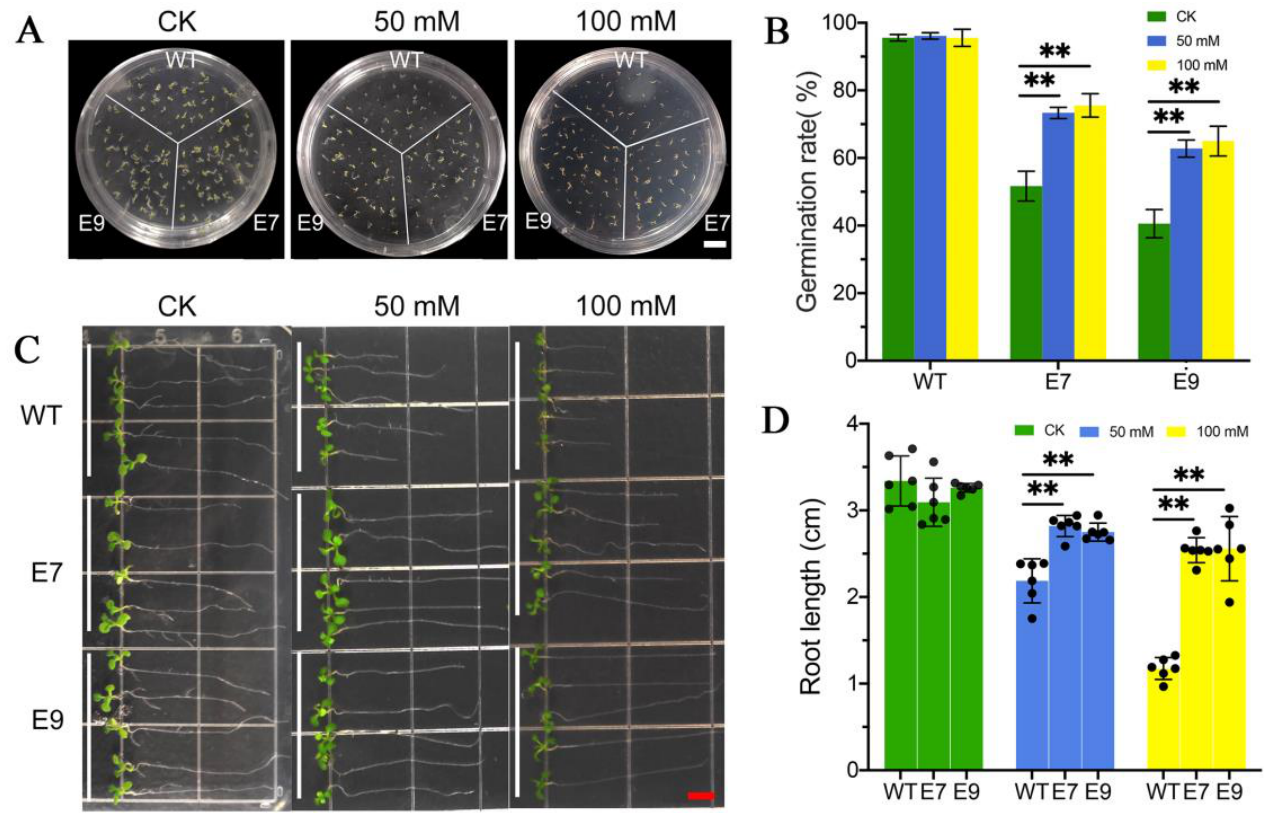
Figure 5. Overexpression of OfELF3 increases germination rate and root length in A. thaliana under salt stress conditions. ( A , B ) Effect of salt stress on the seed germination rate. Scale bars = 1 cm. ( C , D ) Effect of salt stress on root length. Scale bars = 5 mm. The error bars indicate the SD values from at least three repeats of each treatment. ** p < 0.01, t test.